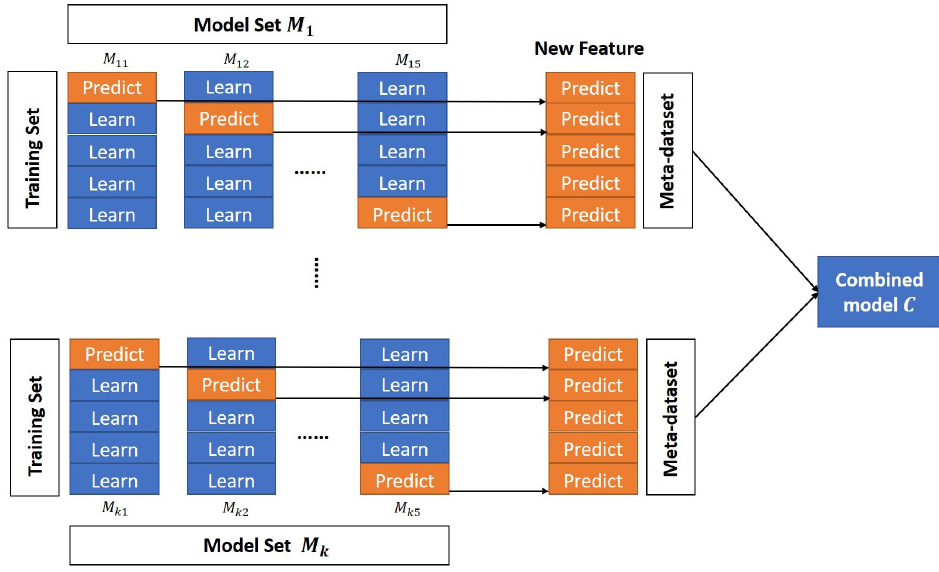
Figure 2. Multi-model combination